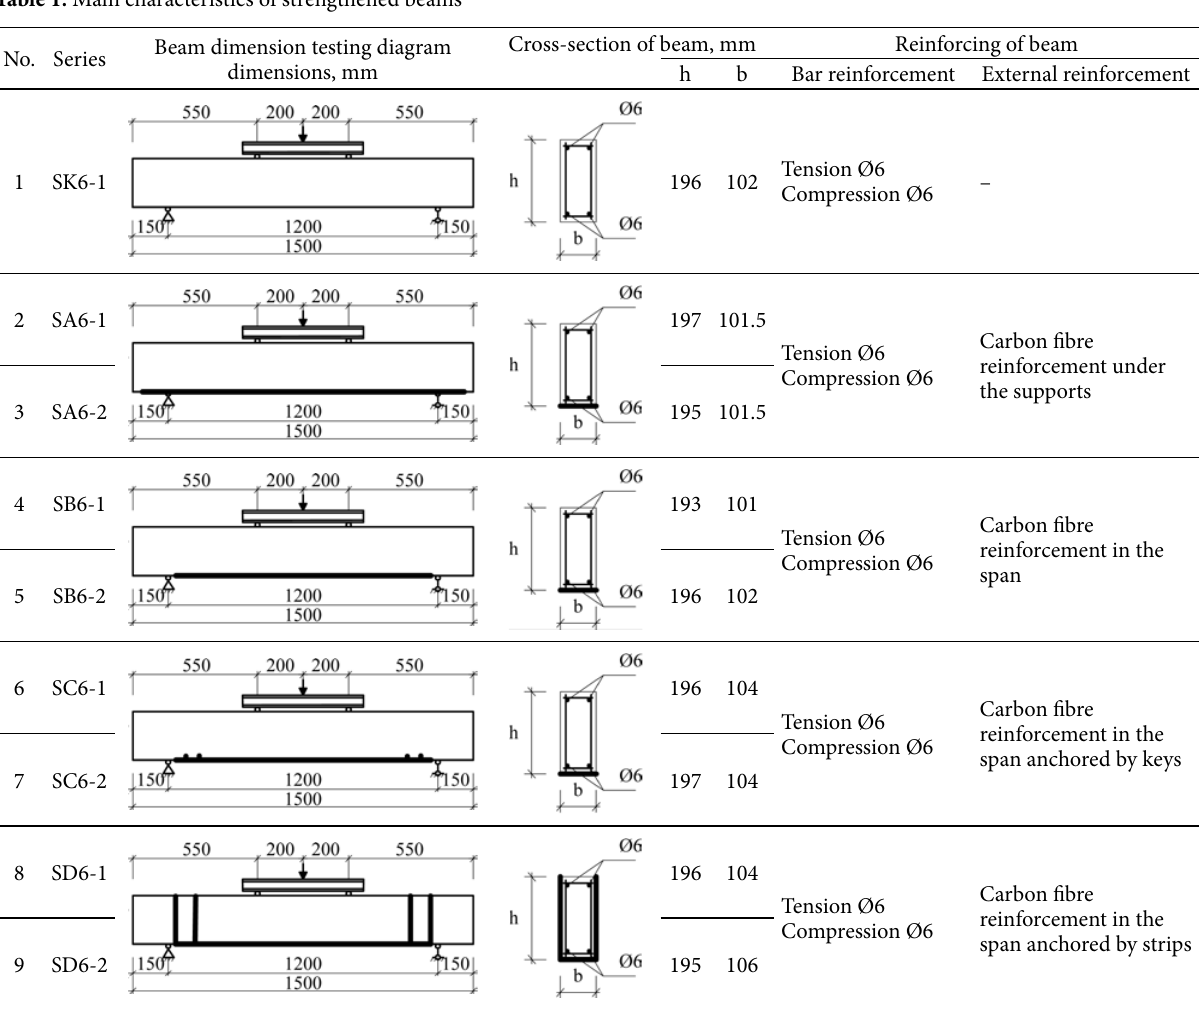
Table 1. Main characteristics of strengthened beams Beam dimension testing diagram No. Series dimensions, mm